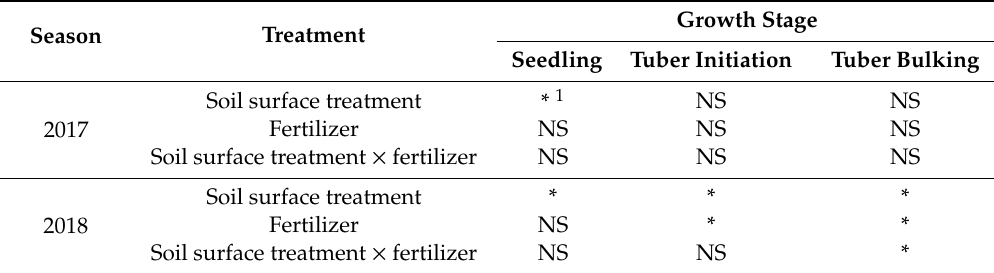
Table 3. The e ff ect of di ff erent treatments on potato leaf area index was analyzed by analysis of variance in 2017 and 2018 using SPSS.